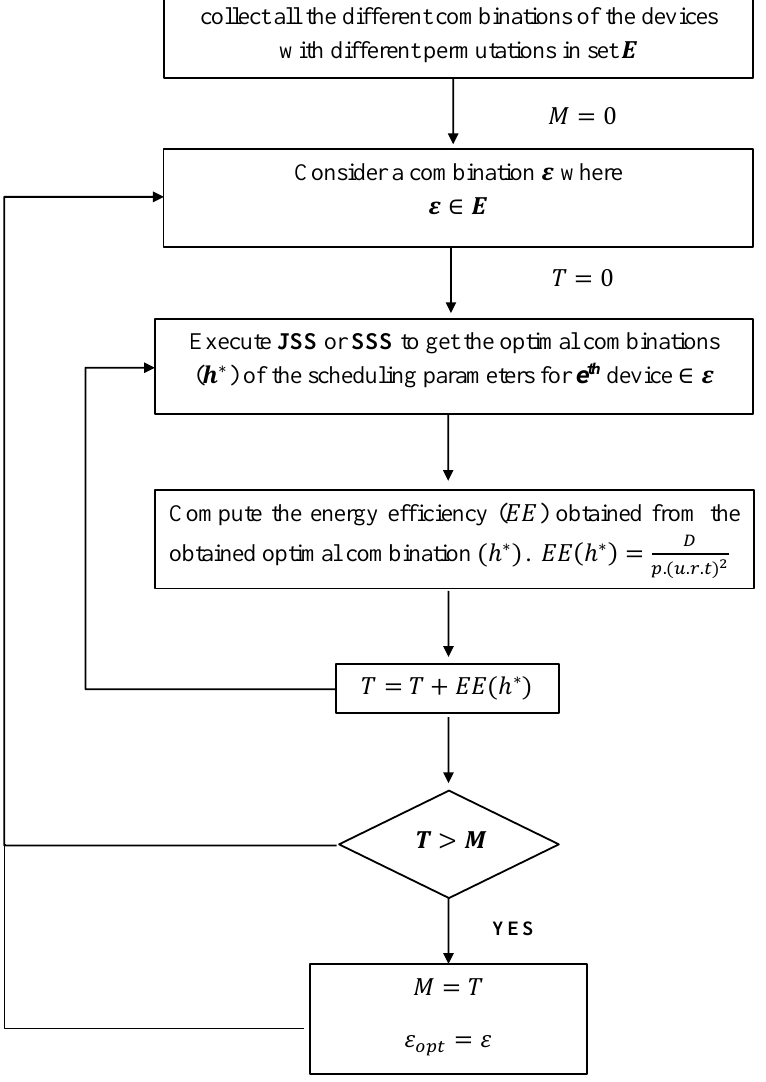
Figure 3. Block diagram describing steps of the exhaustive search technique